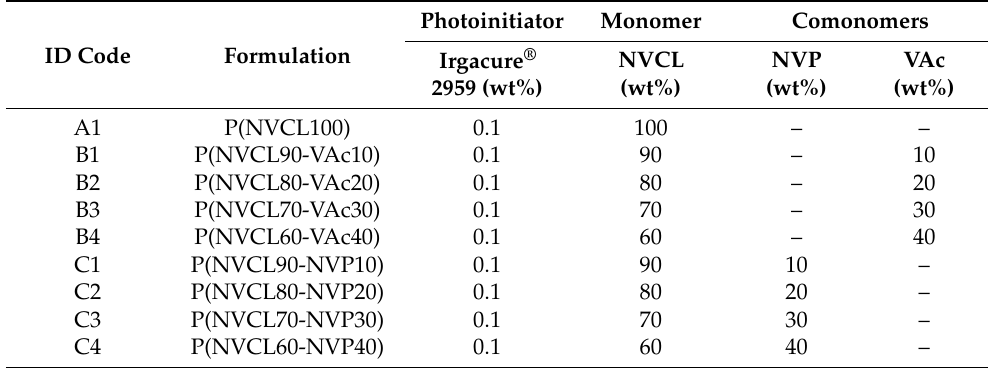
Table 2. Code and compositions of copolymerised